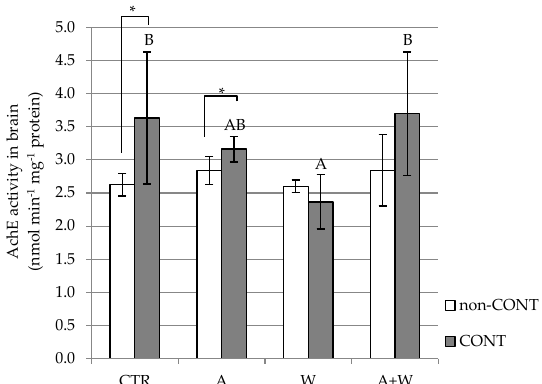
Figure 5. Acetylcholinesterase (AchE) activity (nmol · min − 1 · mg − 1 protein, mean ± SD) in S. senegalensis brain, after 28 days of Hg exposure. White bars represent non-contaminated treatments (non-CONT) and gray bars represent Hg-contaminated treatments (CONT). CTR—seawater temperature set at 19 ◦ C and pH set at 8.0 units; A—seawater temperature set at 19 ◦ C and pH set at 7.6 units; W—seawater temperature set at 23 ◦ C and pH set at 8.0 units; A + W—seawater temperature set at 23 ◦ C and pH set at 7.6 units. Di ff erent small letters denote significant di ff erences between non-CONT treatments (ANOVA, p < 0.05). Di ff erent capital letters denote significant di ff erences between CONT treatments (ANOVA, p < 0.05). Asterisks (*) represent di ff erences between non-CONT and CONT for the same conditions (Student’s t -test: * p < 0.05).